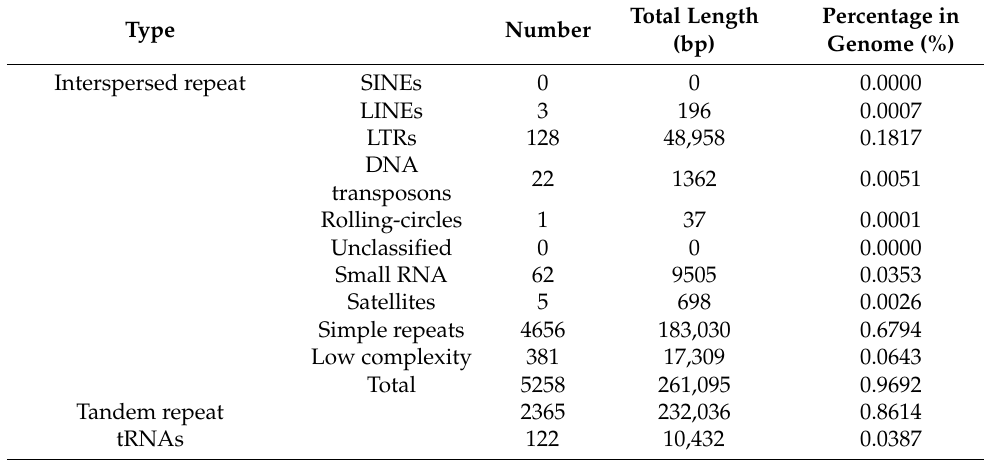
Table 2. Statistical results of repetitive sequences and noncoding RNAs for the Emericellopsis cladophorae MUM 19.33